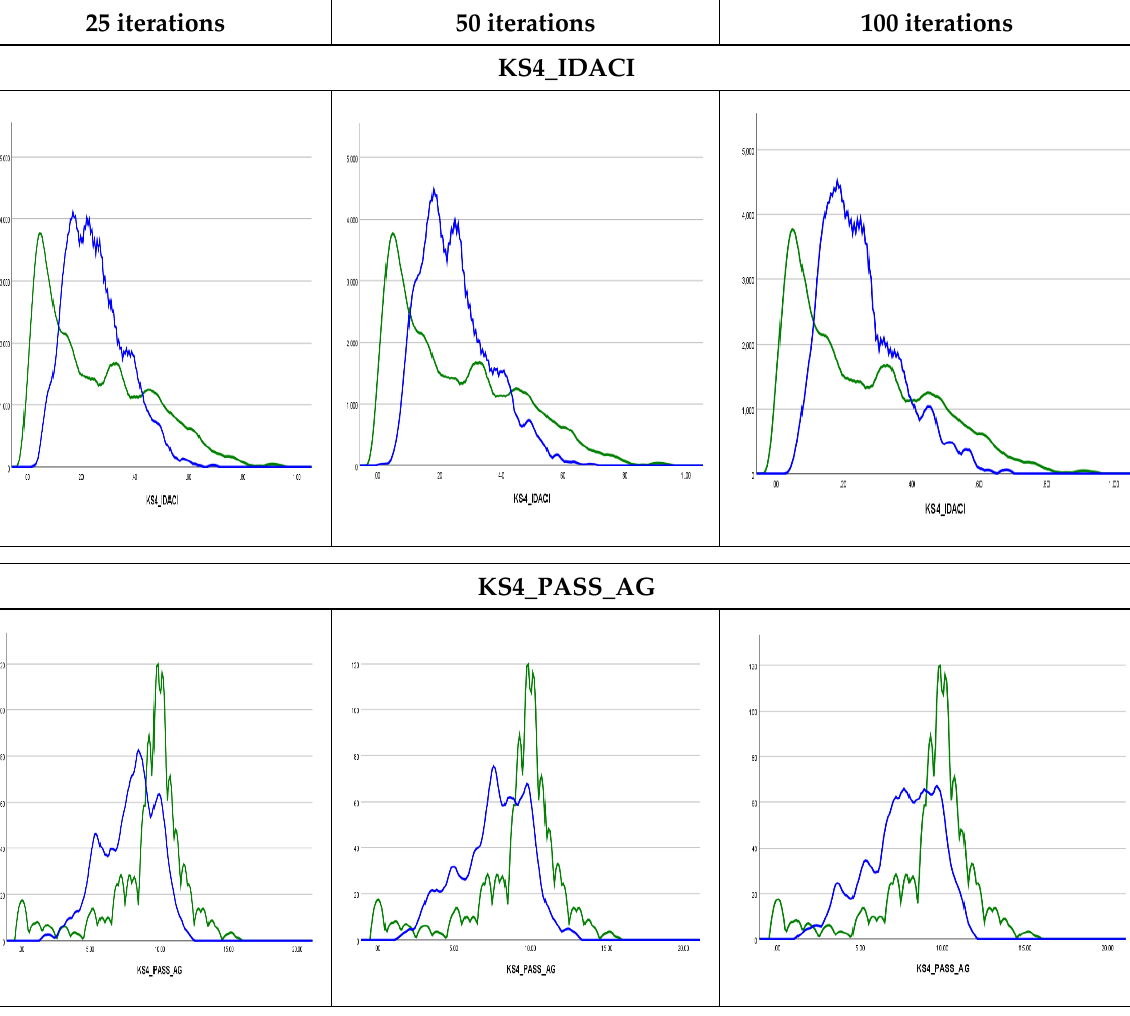
Figure 3. Kernel density plots. Observed values are presented by the green curve and the imputed values are presented by blue curve.